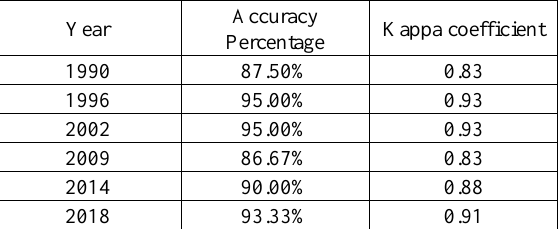
Table2. Accuracy assessment of land use classification of